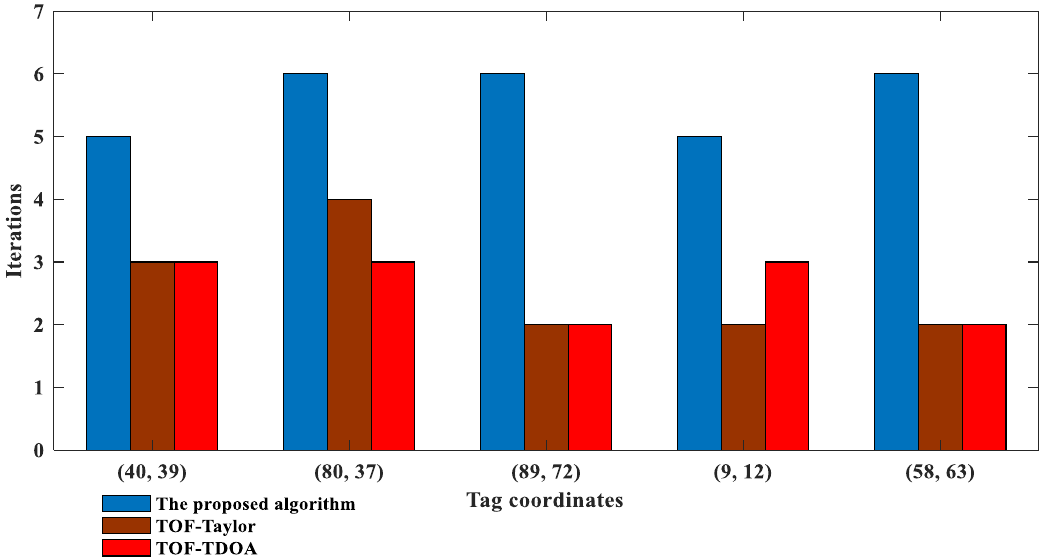
Figure 6. Iterations of the proposed positioning algorithm under different tag coordinates. Table 1. Performance evaluation of the proposed positioning algorithm.